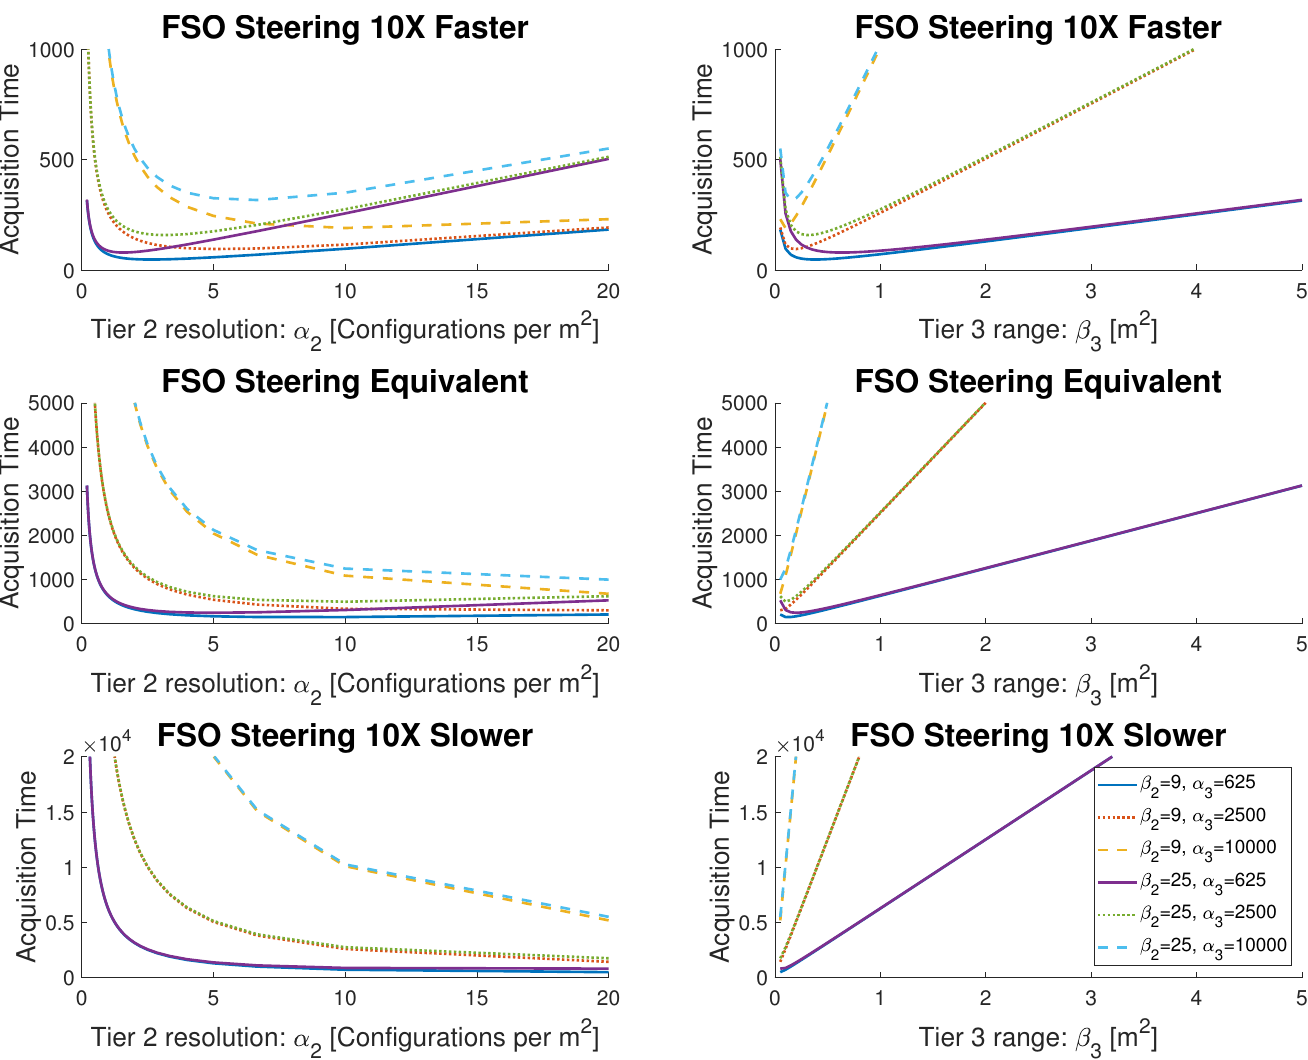
Figure 7. Maximum search time for MTH protocol as a function of Tier 2 resolution (i.e., α 2 ) and Tier 3 range (i.e., β 3 ). Results are shown for: t 2 / t 3 = 10 ( top ); t 2 = t 3 ( middle ); and t 2 / t 3 = 0.1 ( bottom ). The legend in the bottom right plot is common to all